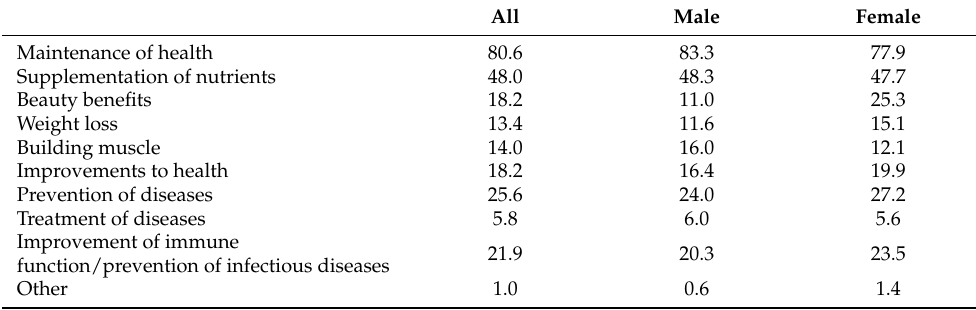
Table 11. Purpose of use of mineral-fortified food/mineral